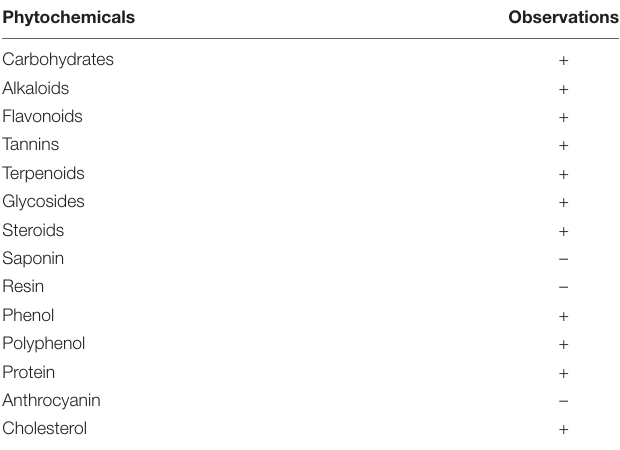
TABLE 1 | Qualitative phytochemical screening of the methanol extracts of Dillenia pentagyna. Phytochemicals Observations